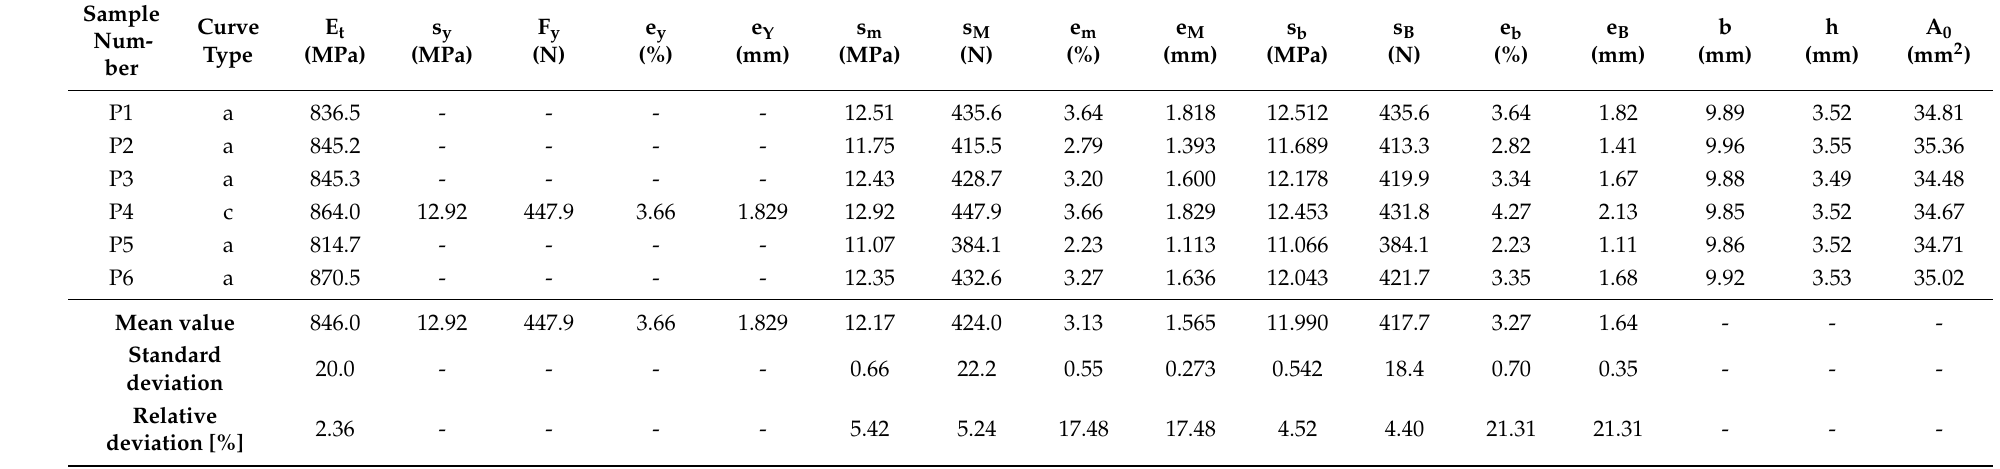
Table A43. Results of the tensile tests of